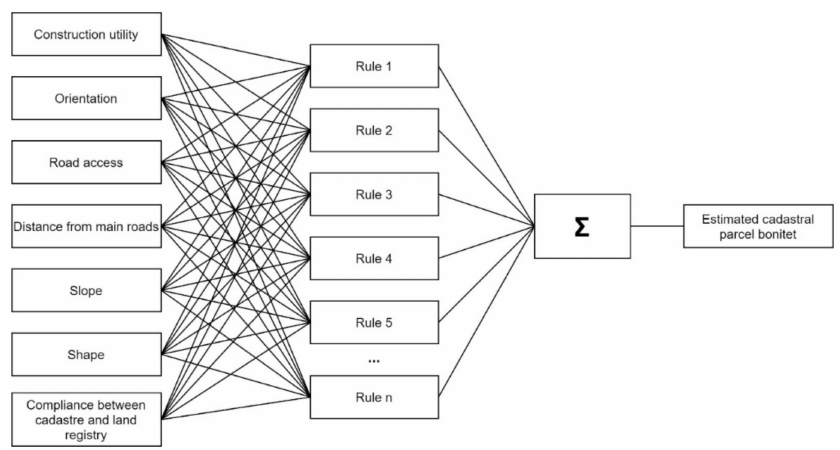
Figure 5. Input and output variables to estimate of cadastral parcel